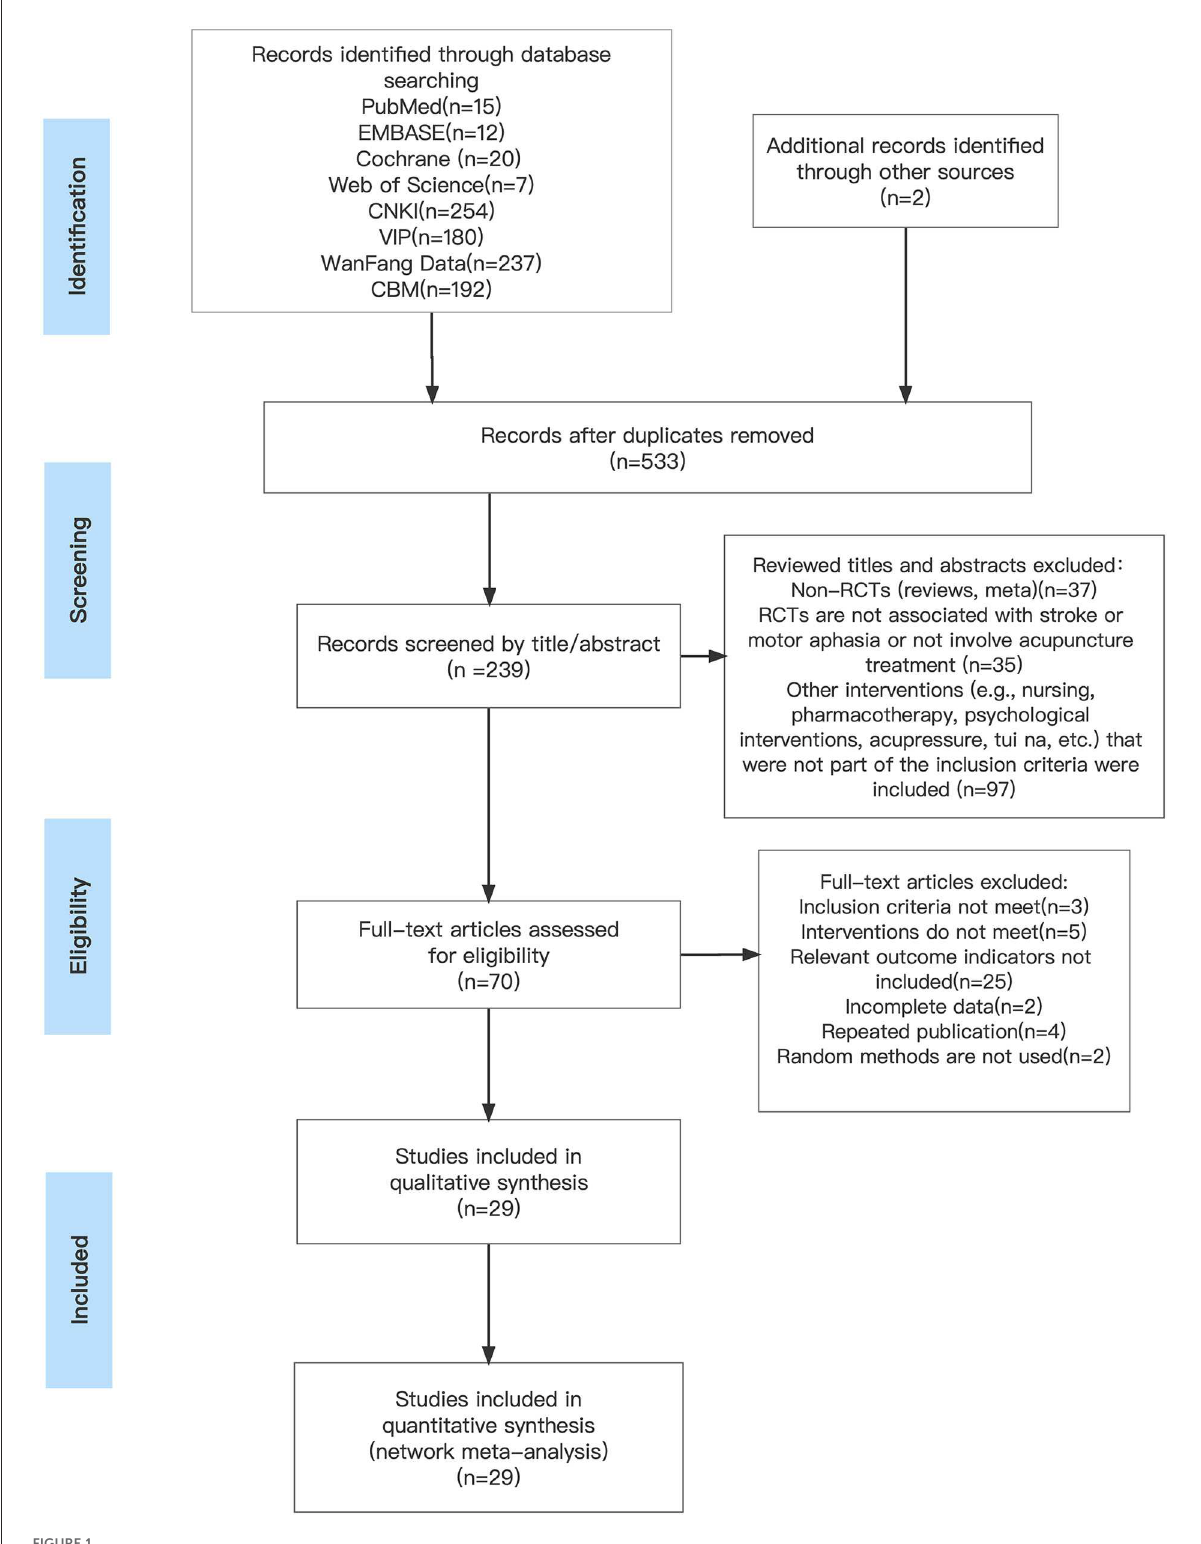
FIGURE1 Literature screening